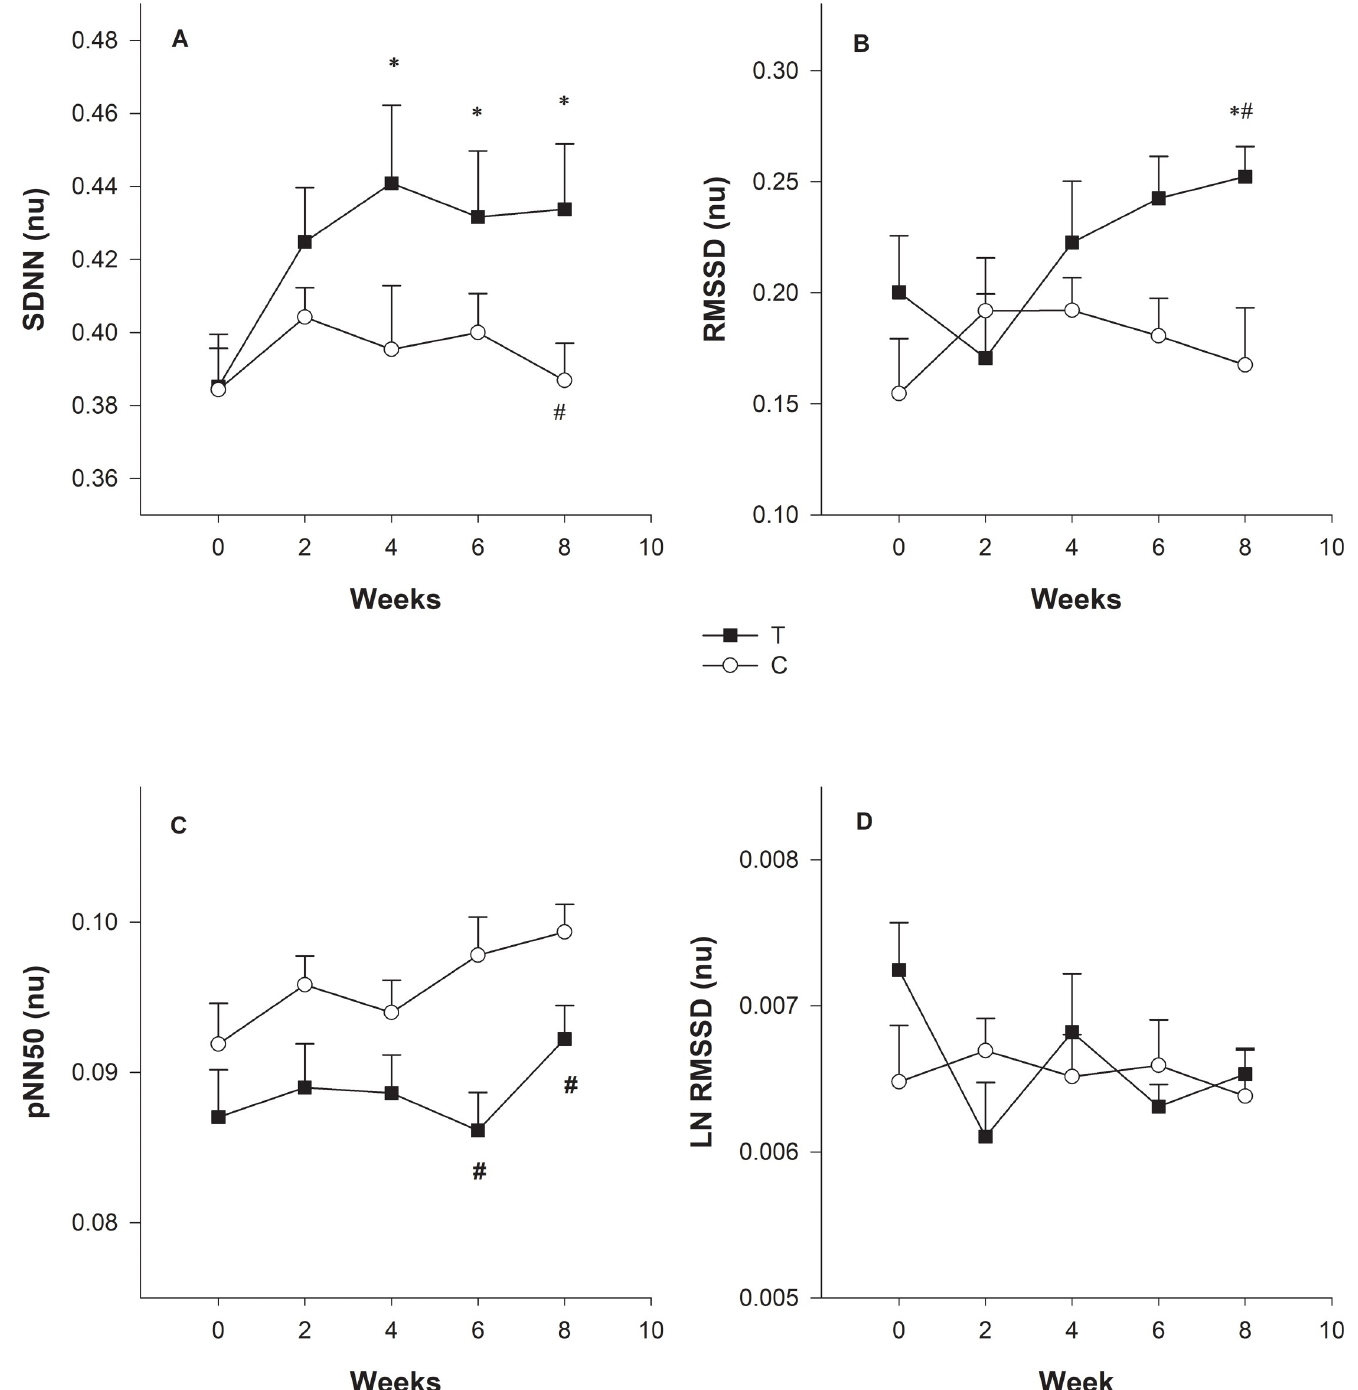
Fig 8. Changes in time-domain measures on heart rate (HR mean ) and heart rate variability (HRV) in dogs undergoing 8-week physical training. SDNN: standard deviation of all normal RR intervals (A); RMSSD: the square root of the mean of the squared differences between adjacent normal RR intervals (B); pNN50: percentage of differences between adjacent normal RR intervals that are > 50 ms (C); LnRMSSD: natural logarithm of the square root of the mean sum of the squared differences between R–R intervals (D). The data without and with HR correction (RMSSD/meanRR, pNN50/meanRR and Ln RMSSD/meanRR). nu, normalized units following HR correction. Bars are standard errors. # Indicates difference between groups; � Indicates difference in relation to week 0; (p < 0.05).